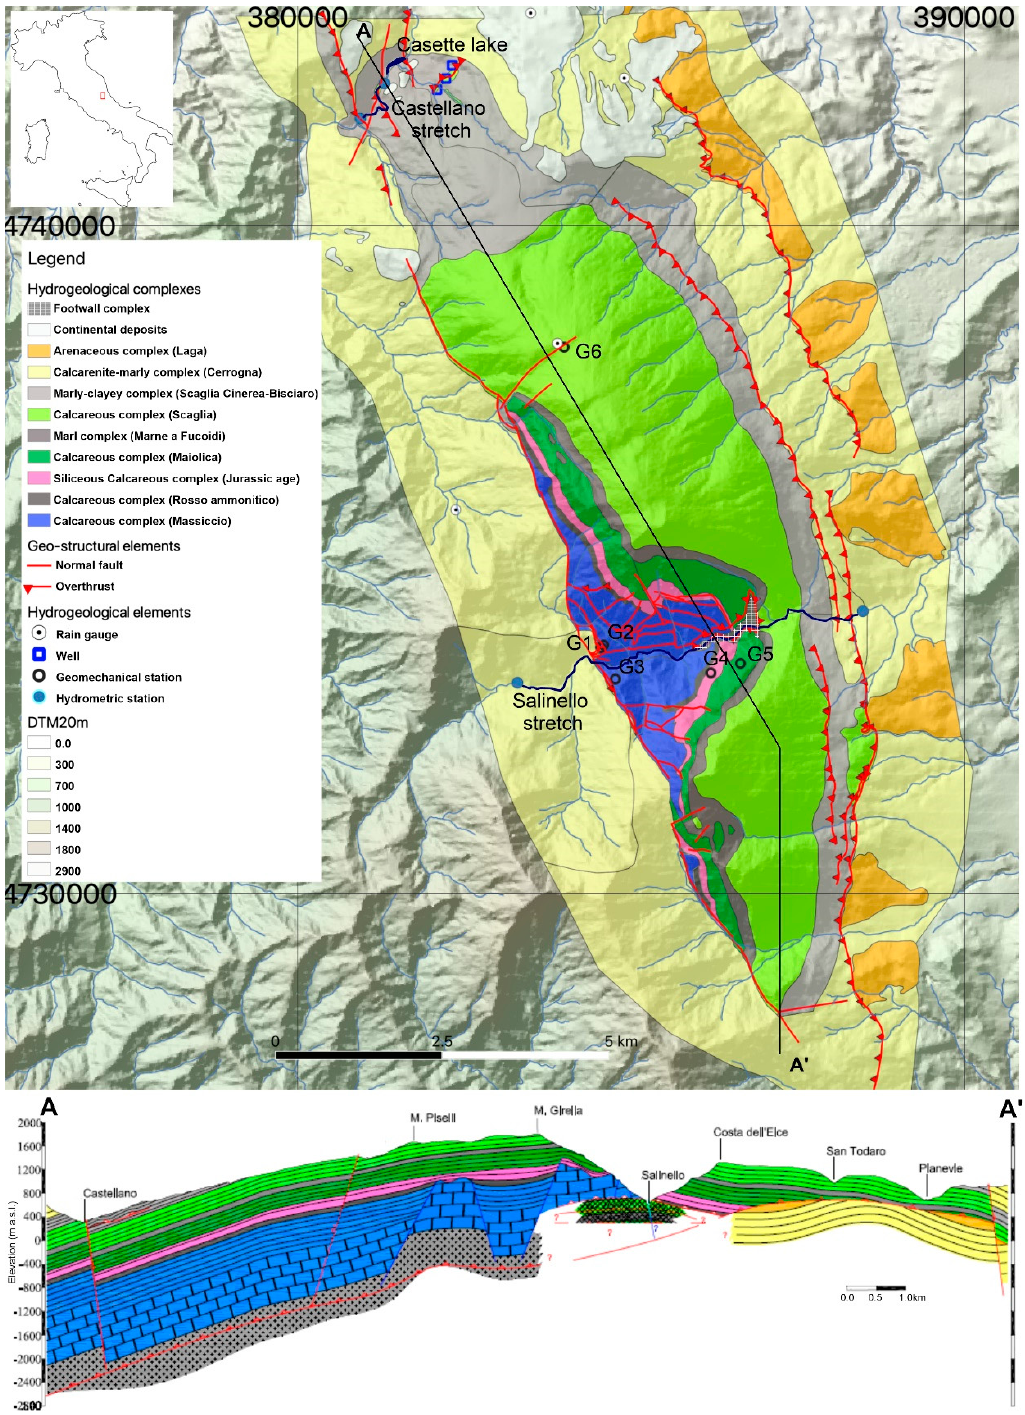
Figure 1. Hydrogeological map of the “Montagna dei Fiori” hydrostructure used to build up the numerical model domain.